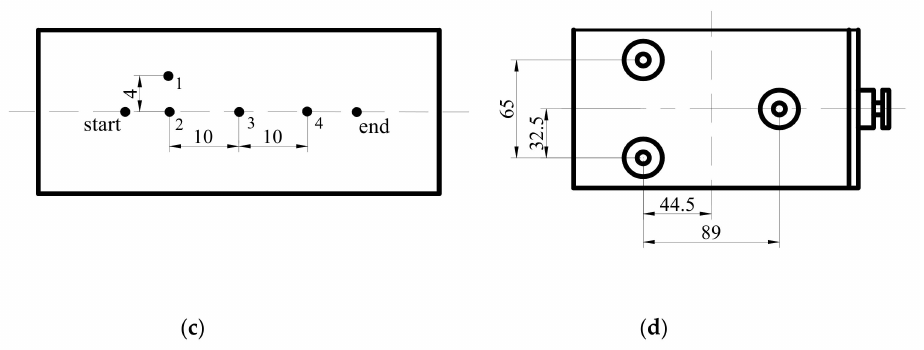
Figure 2. Welding temperature and welding force measuring device and distribution map: ( a , b ) physical diagram; ( c , d ) distribution map.